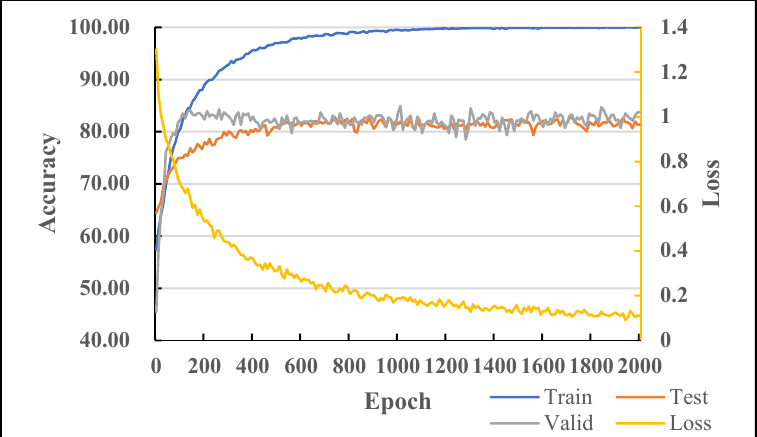
Figure 5. The results of combined POI and building.